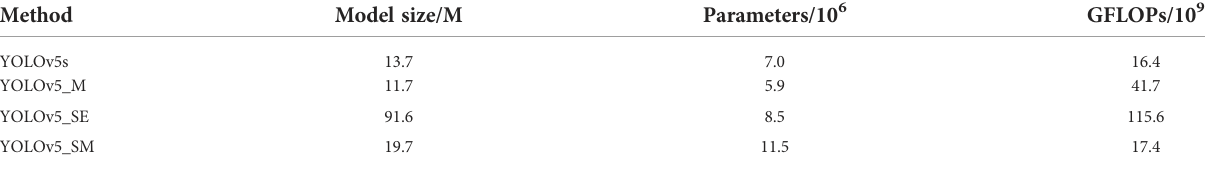
TABLE 4 Comparison of model parameters.